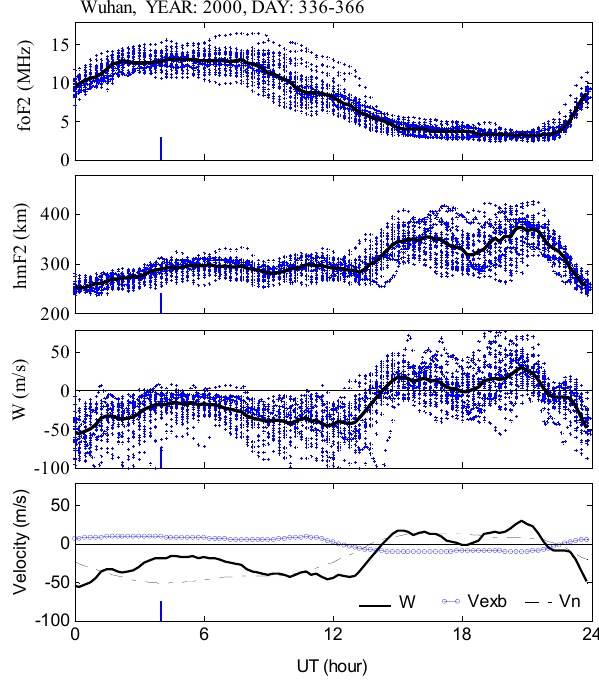
Fig. 8. Diurnal variations in median foF2 and hmF2, and averaged vertical components of equivalent winds (solid line), and those of E × B drifts (line with circles) and neutral winds (dot-dashed line) during days 336–366, 2000. Superposed individual points present measured or deduced data in this month. Local noon is indicated with a short vertical line at the bottom of each panel.